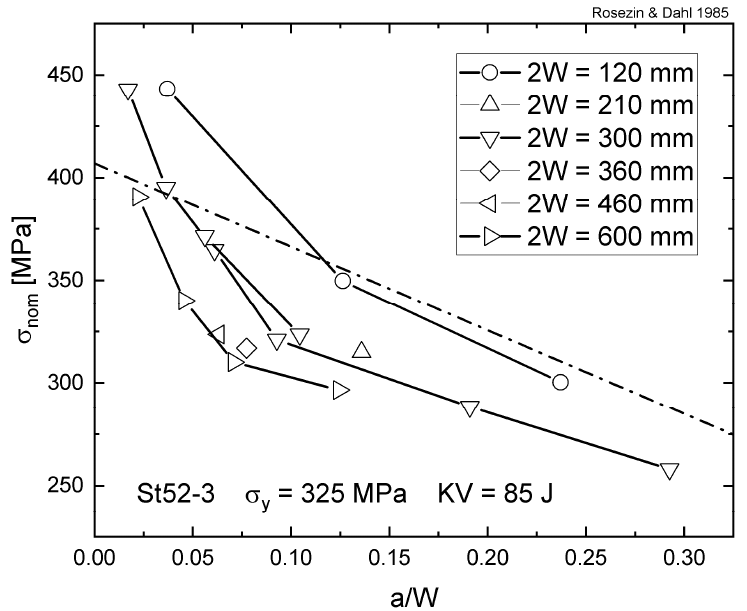
Figure 14. CC(T) test maximum load (nominal stress) values for different specimen widths, as a function of relative crack length a/W [11].